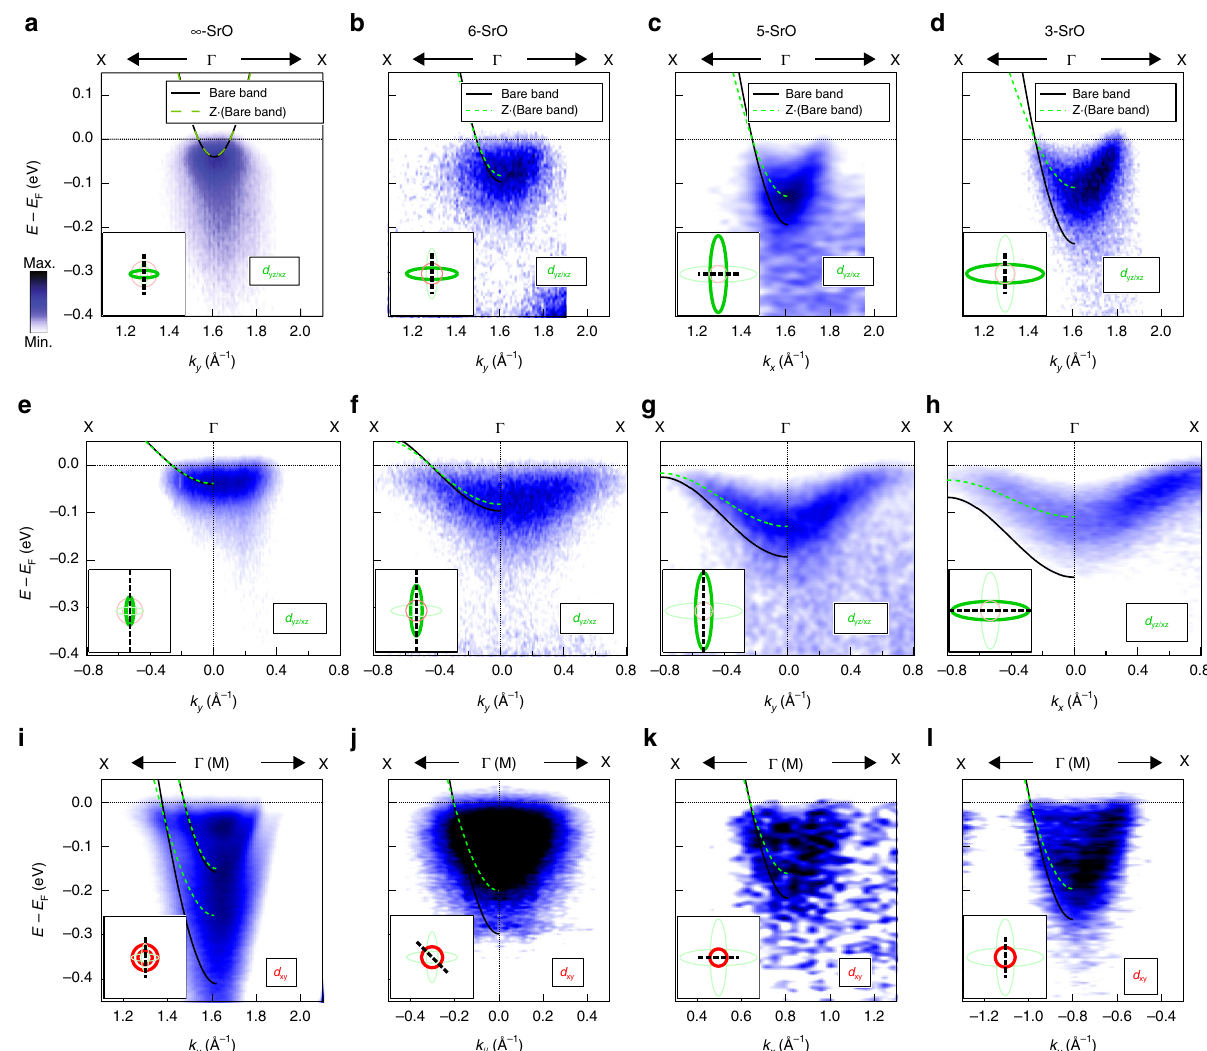
¼ 1 - ( a ), 6- Fig. 2 Evolution of electronic structures at the interfaces for different quantum well structures. ARPES spectra for light band d yz = xz orbital ( t QW ¼ 1 - ( e ), 6- ( f ), 5- ( g ), and 3- ( h ) SrO). ARPES spectra of energy versus momentum ( b ), 5- ( c ), and 3- ( d ) SrO). ARPES spectra for heavy band d yz = xz ( t QW ¼ 1 - ( i ), 6- ( j ), 5- ( k ), and 3- ( l ) SrO). Only 1 -SrO shows clear evidence of two parabolic sub- cuts for d xy orbital as a function of number of layer ( t QW bands. The insets in each fi gure show the locations of the cuts. The black solid lines and green dashed lines are the bare bands based on DFT of bulk SrTiO 3 and the renormalized experimental band dispersions, respectively. direction Γ -M (red dashed line). The detailed Fermi surface structure around the X point is shown in Fig. 3h, i. The peak positions in the momentum-distribution curves (MDC) in Fig. 3h, i and the MDCs along M-X-M shown in Fig. 3j delineate a clear change in Fermi surface topology. The dashed lines #1 – 6 in Fig. 3f – i indicate the directions of energy versus momentum cuts along M-X-M (#1, 3, 5, and 7) and Γ -X- Γ (#2, 4, 6, and 8) presented in Fig. 3k – r. The peak positions of MDC (red dots in Fig. 3n, o, q) and energy-distribution curve (EDC) (light-blue dots in Fig. 3n – r) reveal electron- and hole-like dispersion at the X point. Moreover, as shown in Fig. 3o – r clearly, the local minimum and local maximum are observed at the same momentum location, the X point, displaying the emergence of a saddle-point VHS, where the curvatures of bands have opposite signs along two orthogonal directions (schematically illustrated in Fig. 3e). Figure 3s shows the EDCs divided by the Fermi – Dirac function at the X point for each structure indicating the evolution of energy level of VHS. NATURE COMMUNICATIONS| (2019) 10:5534